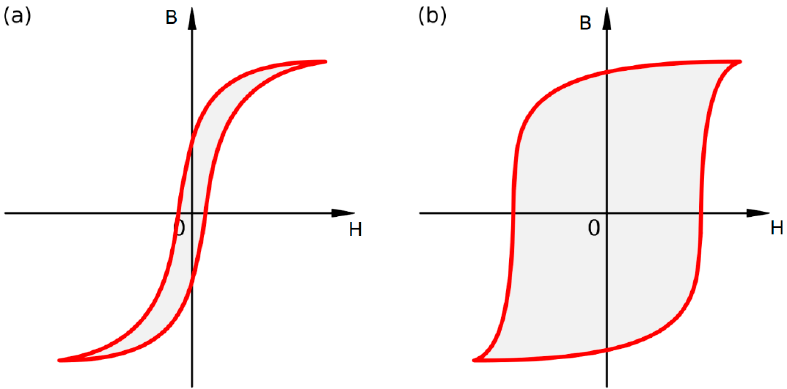
Figure 1. Hysteresis loop ( a ) for a soft magnetic material, ( b ) for a hard magnetic material. Source: own work, based on work by MikeRun, published in the Wikimedia Commons repository, https://commons.wikimedia.org/wiki/File:Hysteresis-comparison.svg (accessed on 14 October 2022).